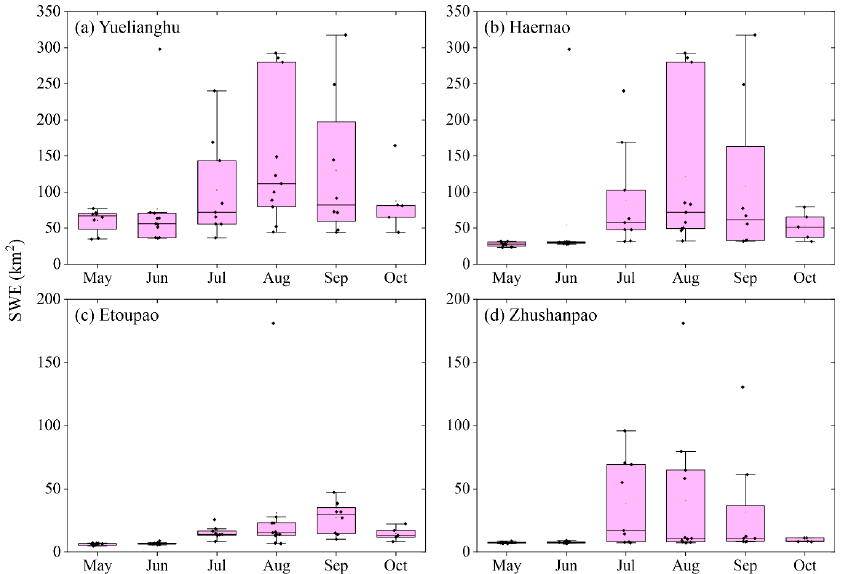
Figure 15. Variations in surface water extent (SWE) of the main connectomes (i.e., seasonally connected water bodies) in the Momoge National Nature Reserve, China from 2015 to 2019. ( a ), Yuelianghu ( b ), Haernao ( c ), Etoupao and ( d ) Zhushanpao.